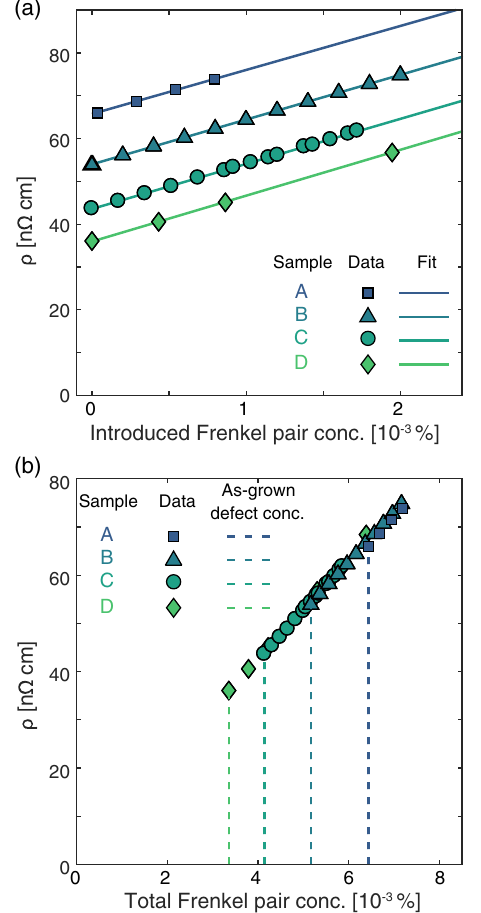
FIG. 9. Resistivity of four PtCoO 2 samples as a function of (a) introduced defect concentration and (b) the total defect concentration, estimated from the interpolation of lines in (a). The dashed lines indicate the effective Frenkel pair concentration in the samples before